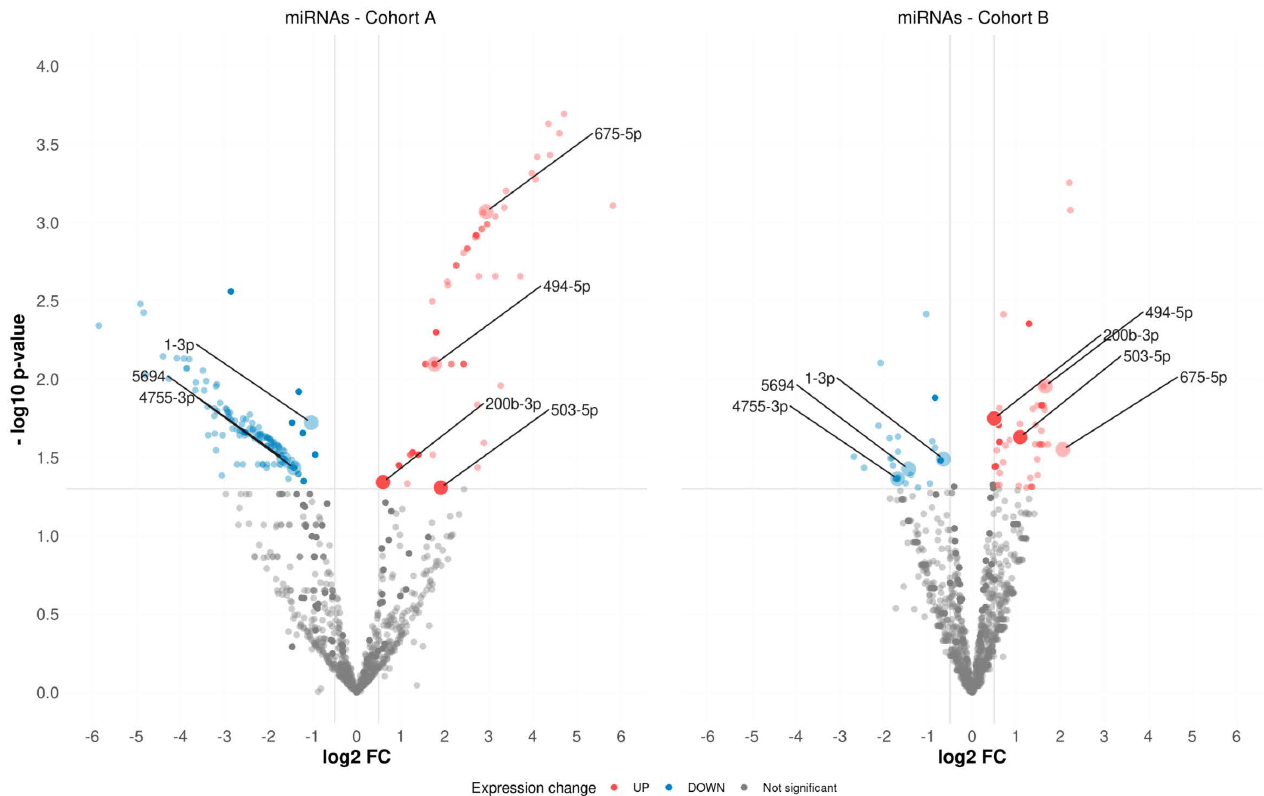
Figure 1. Volcano plot of differentially expressed miRNAs in both cohorts.